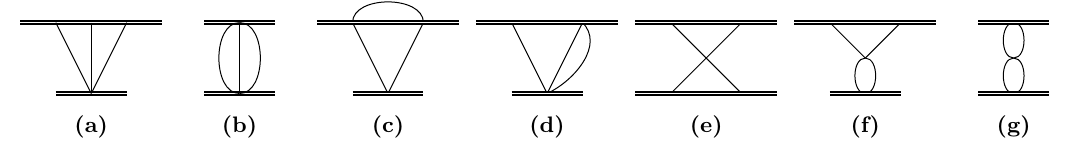
Figure 9. Single-scale integrals appearing as boundary values for two-loop soft